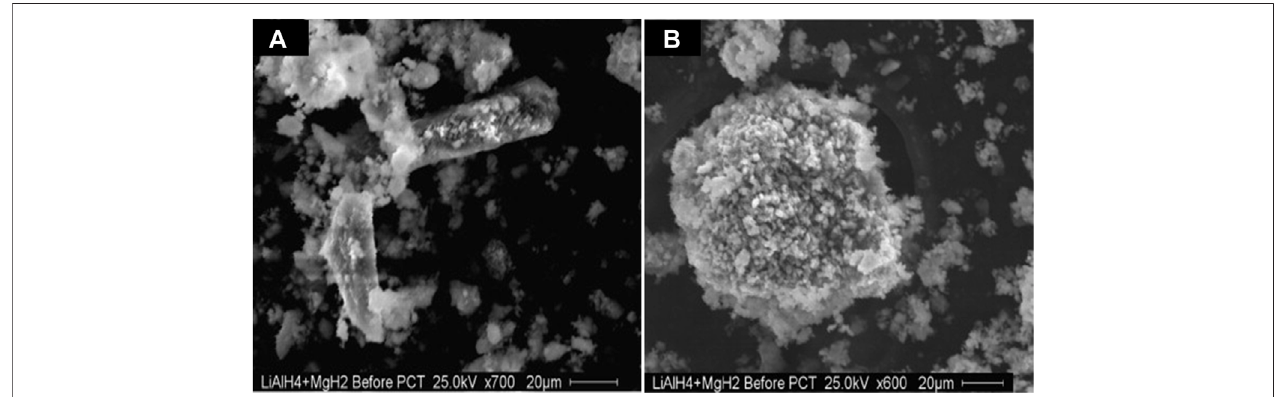
FIGURE 7 | SEM images of LiAlH 4 – nanoMgH 2 (A) after milling for 2 h and (B) after absorption – desorption cycling (Vittetoe et al., 2009).